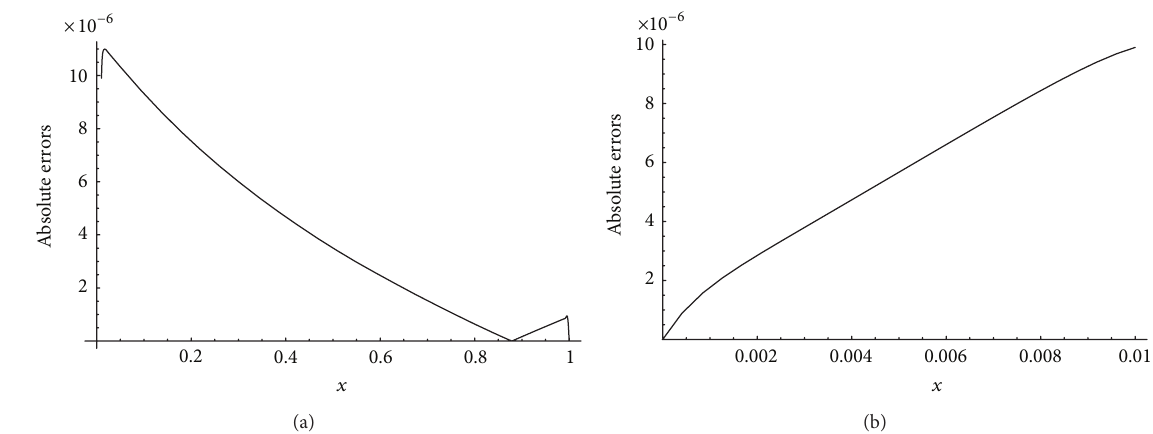
Figure 1: Absolute errors |𝑢(𝑥) − 𝑢 200 (𝑥)| of Example 1 for 𝜀 = 10 −3 ((a): regular domain; (b): boundary later domain).